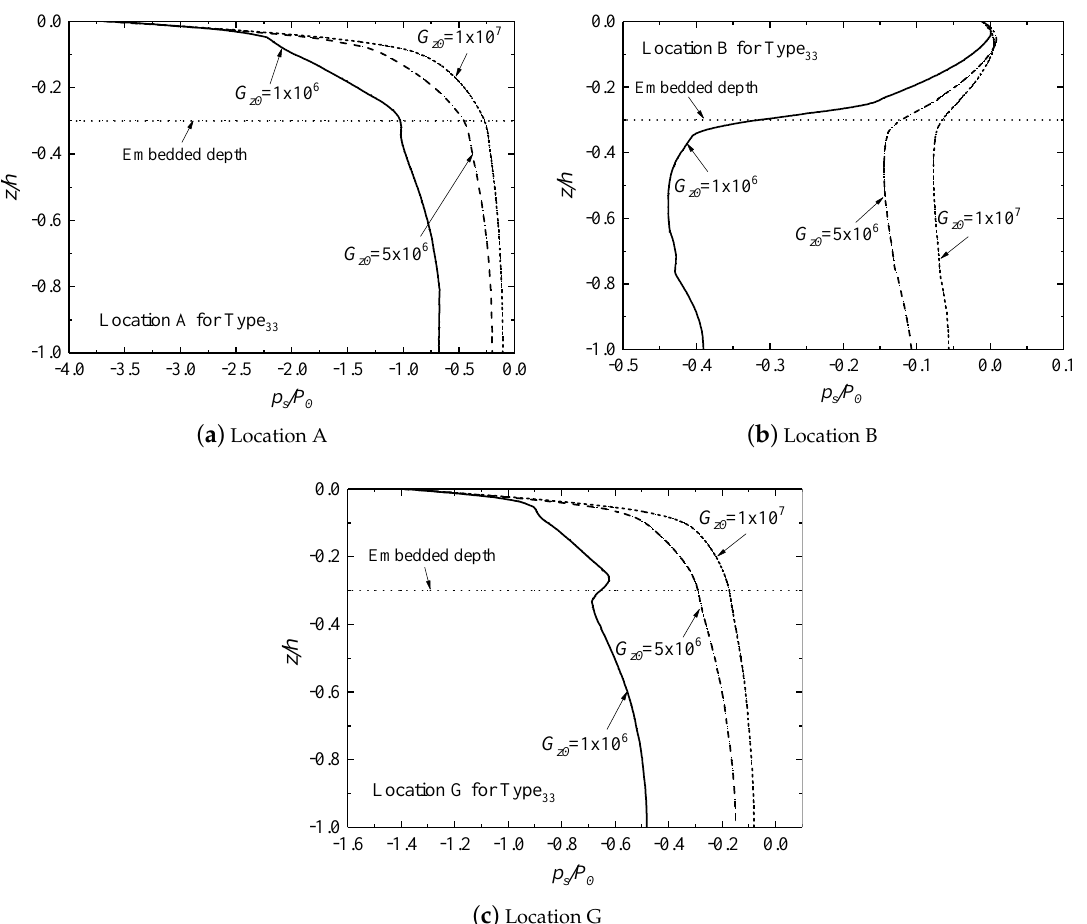
Figure 21. Vertical distributions of pore pressure with various shear modulus at the seabed surface for Type 33 at t = 83.5 s